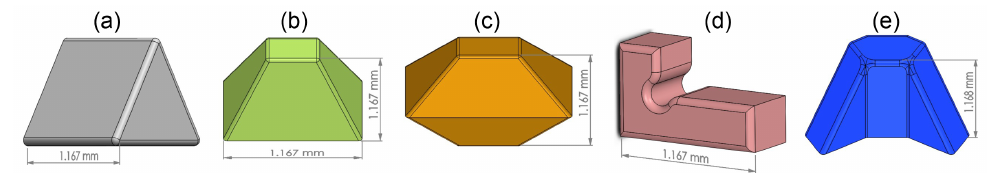
Figure 1. Geometrically defined test particles: ( a ) Triangular prism. ( b ) Truncated pyramid. ( c ) Octahedron. ( d ) L-angle. ( e ) Abstract